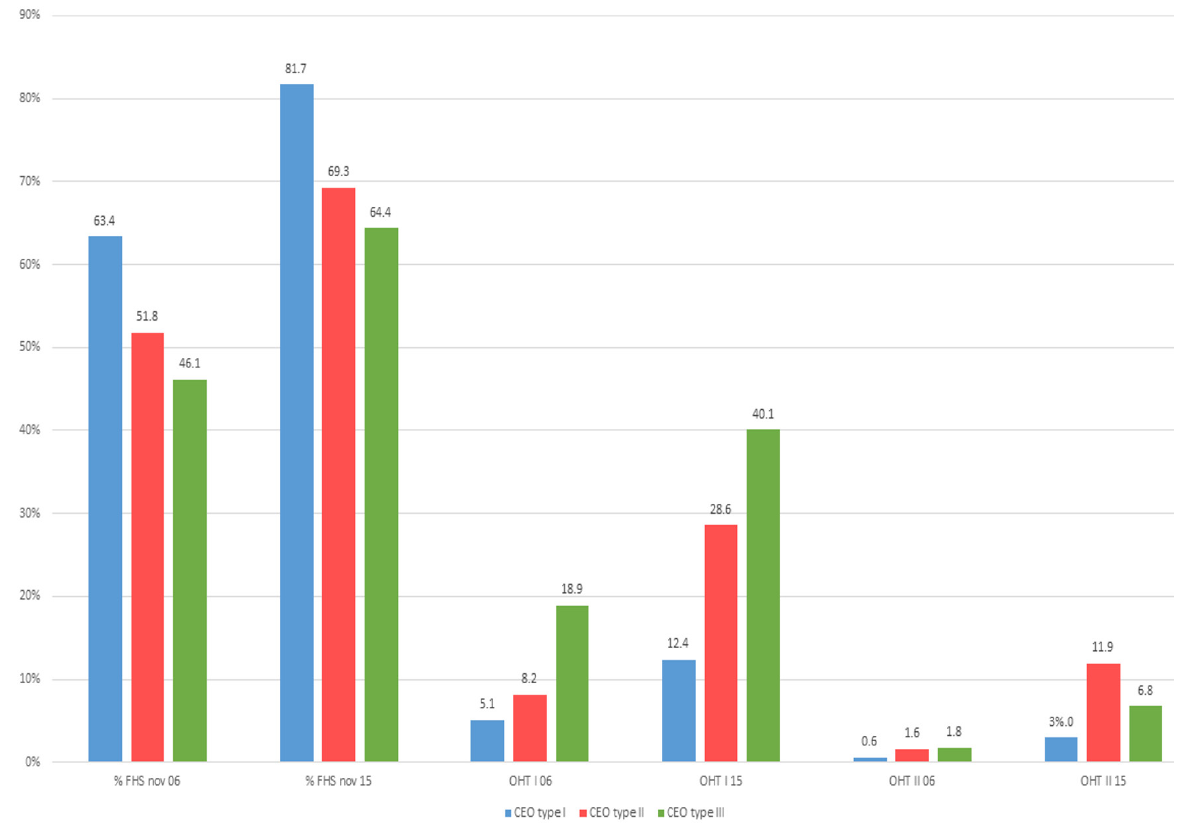
Figure 1 - Percentage means of the FHS coverage and the number of OHT I and II, by type of CEO at both collection times (January 2006 and November